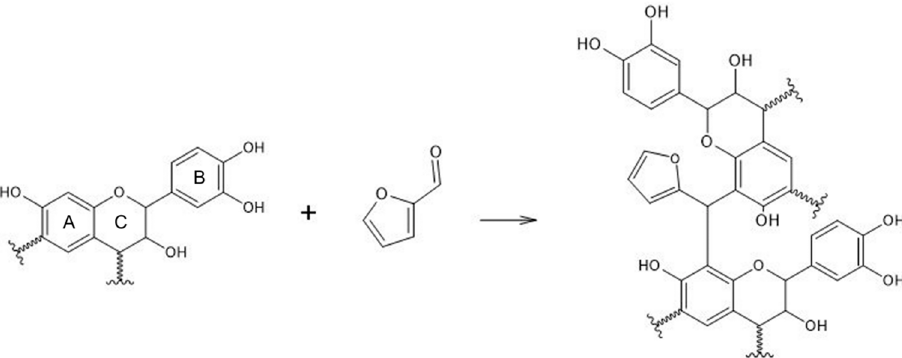
Figure 3. Possible product from Quebracho tannin and furfural reaction.